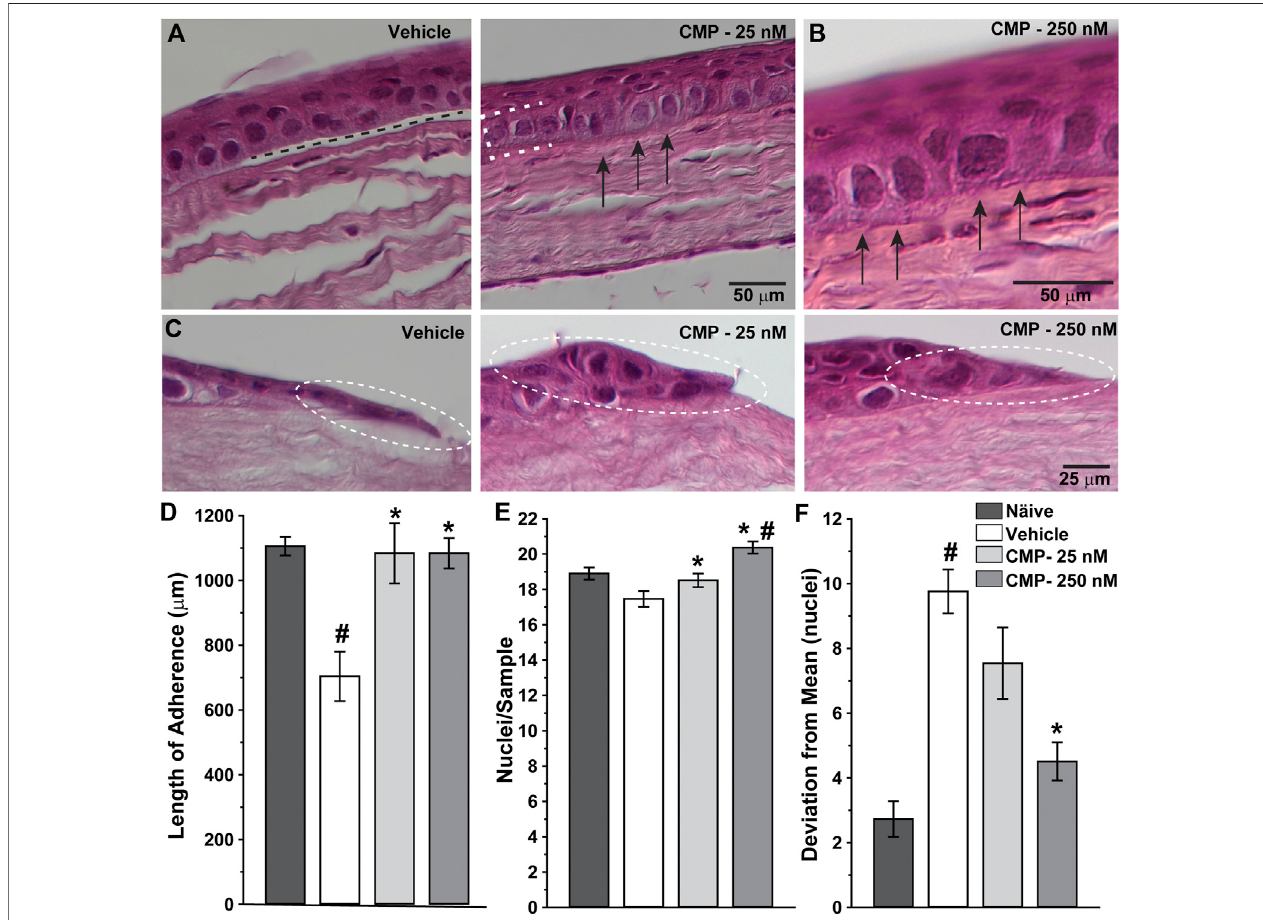
FIGURE 4 | CMP enhances the structure of healing corneal epithelium. Representative differential interference contrast images of histological sections with hematoxylin and eosin staining through regenerated epithelium ( A , B ) and the proliferative edge (C) 24 h following induced corneal injury. While vehicle-treated eyes demonstratedfrequentgapsbeneaththeepithelium( A ,left;dashedline),treatmentwithCMPenhancedadherenceofthebasallayer(brackets)totheunderlyinganterior stromal surface(arrows)forboth25( A ,right)and250 nM ( B ,athigher magni fi cation)concentrationsofCMP.Attheproliferative edgeofthewound (C) ,compared to a vehicle, CMP increases the number of new epithelial cells adhering to the corneal stroma (circles). (D) Length of contiguous segments of adherence between basal epithelium and underlying stromal layer calculated from random samples of histological sections through cornea 24 h following epithelial removal ( n (cid:2) 6 – 11 each). Compared to naïve eyes, vehicle-treated corneas demonstrated a 36% reduction in the average length of adherent surface (#: p < 0.001). Treatment with CMP signi fi cantlyincreasedadherencecomparedtoavehicle(*: p ≤ 0.02),comparabletoadherenceinnaïvecorneas( p ≥ 0.37). (E) Thenumberofepithelialcellnucleiinbasal layerquanti fi edinrandomsamples( n (cid:2) 29 – 100each).TreatmentwithCMPincreasedthenumberofcellspersamplesigni fi cantlycomparedtoavehicle(*: p ≤ 0.04);the numberofcellsfollowing250 nMCMPtreatmentexceedednaïve(#: p (cid:2) 0.008) (F) .Deviationinthenumberofepithelialnucleiineachrandomsamplefrom( A )compared to the mean number for each cohort. The vehicle group was signi fi cantly more variable than naïve (#: p < 0.001); treatment with 250 nM CMP reduced deviation by 54% compared to a vehicle (*: p < 0.001) but remained higher than naïve ( p (cid:2) 0.04).